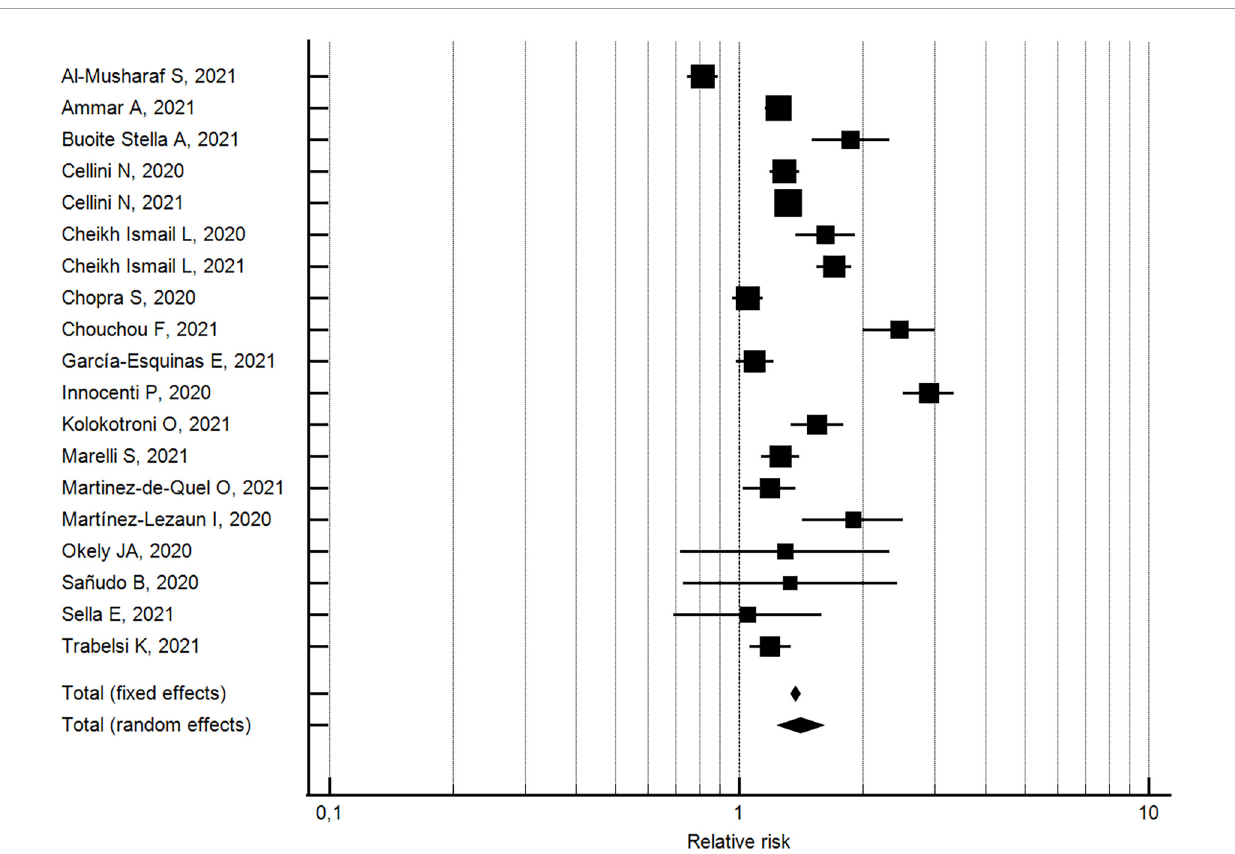
FIGURE3 Forest plot showing pooled changes in poor sleep quality from before to during the COVID-19 lockdown. Error bars = 95% confidence interval; Square boxes = individual point estimates; and Diamond box = pooled point